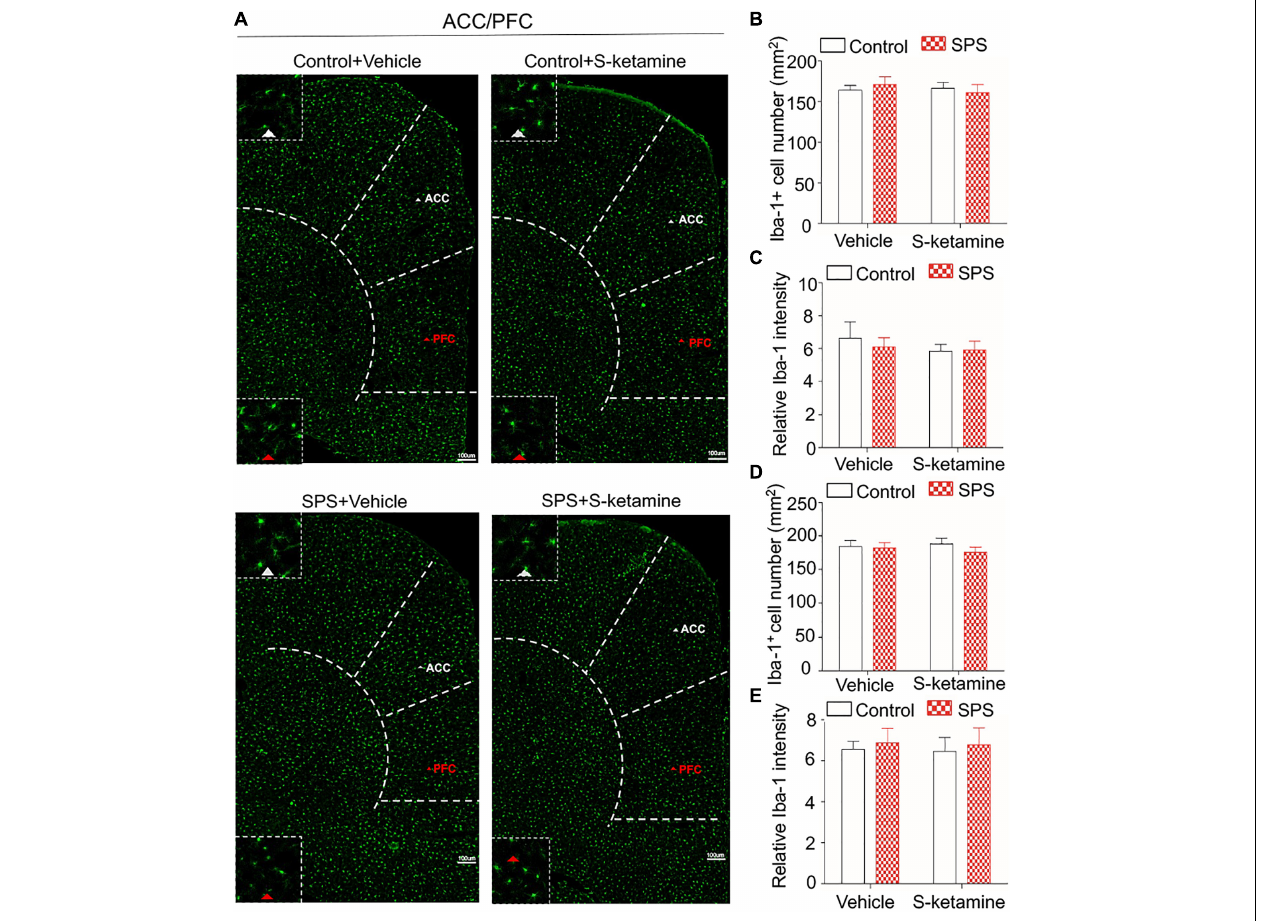
FIGURE 4 | S-ketamine does not influence the microglial activation in the anterior cingulate cortex and prefrontal cortex. Rats were randomly assigned into control + vehicle group, SPS + vehicle group, control + S-ketamine 5 mg/kg group and SPS + S-ketamine 5 mg/kg group. n = 3 per group. (A) Immunofluorescence staining of Iba-1 in ACC and PFC. (B) The number of Iba-1-positive stained cells in the ACC. (C) Relative intensity of Iba-1-positive stained cells in the ACC. (D) The number of Iba-1-positive stained cells in the PFC. (E) Relative intensity of Iba-1-positive stained cells in the